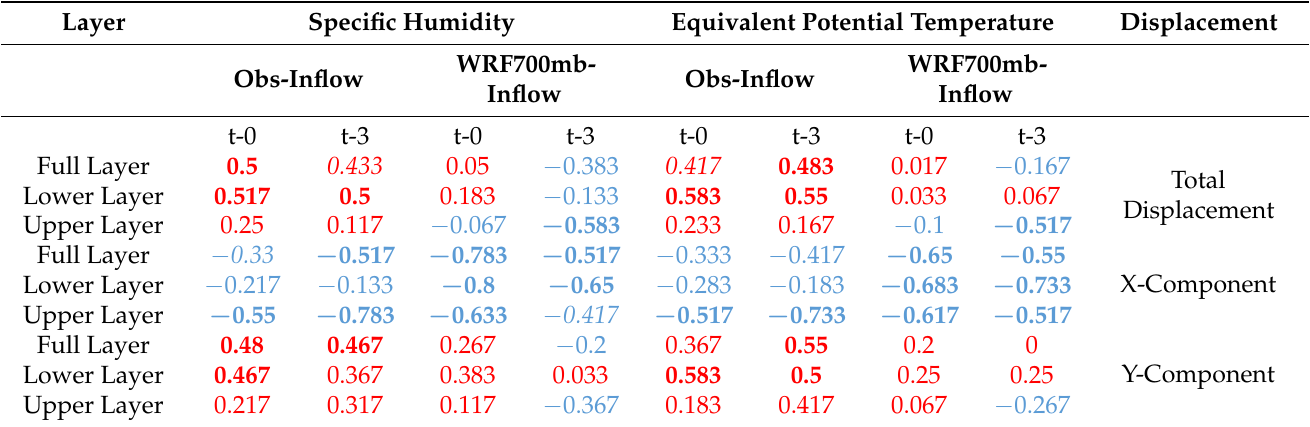
Table 3. As in Table 1 except for Type A